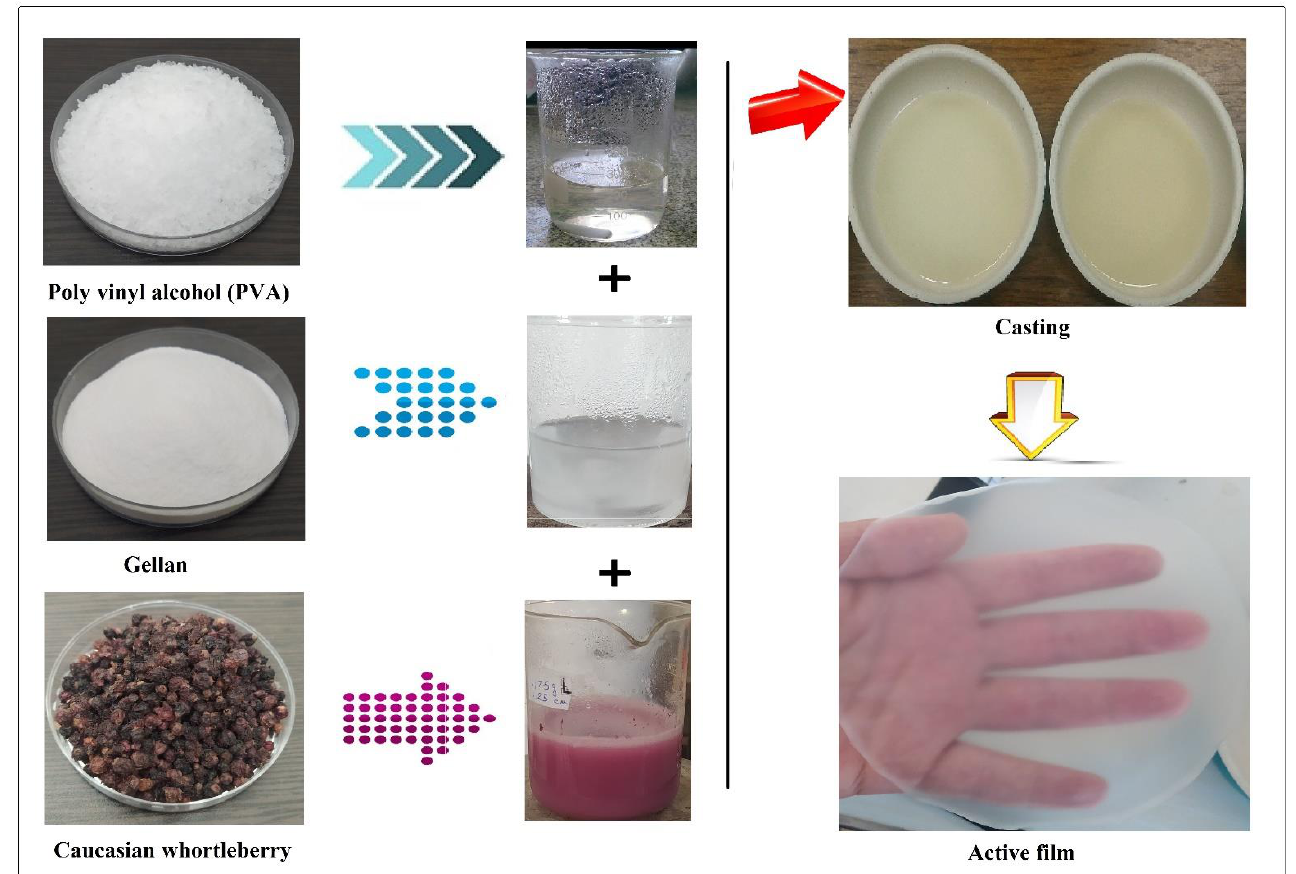
Figure 1. Schematic of the process used to produce the active Figure 1. schematic of the process used to produce the active films.